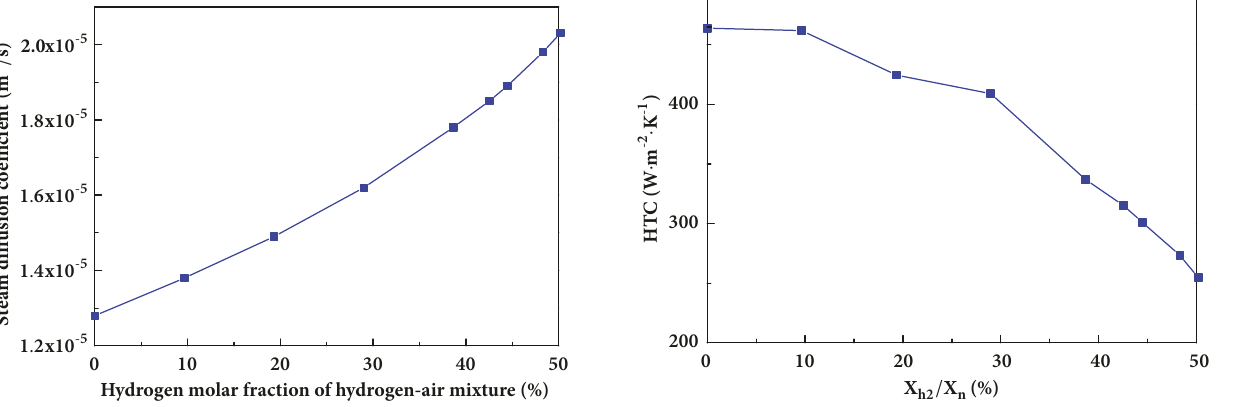
Figure18:Steamdiffusioncoefficientwithdifferenthydrogenmolar fractions.